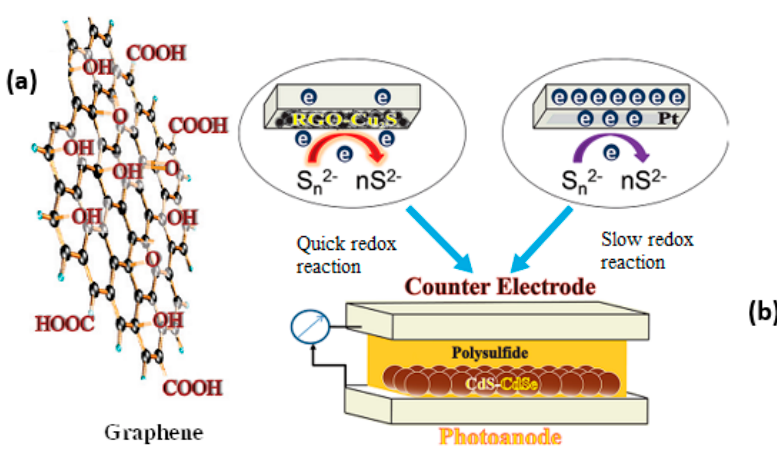
Figure 10. ( a ) Graphene with functional groups and ( b ) structure of a QDSSC from Tachan and co-works, 2011 [133].